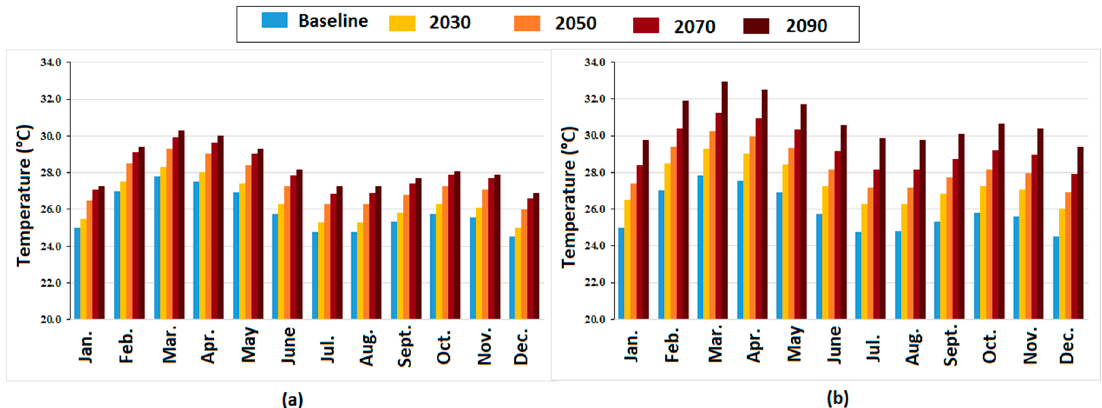
Figure 4. Variation in the monthly interannual mean temperatures for Horizons 2030, 2050, 2070, and 2090 in the Sassandra River Basin: ( a ) RCP 4.5; ( b ) RCP 8.5.